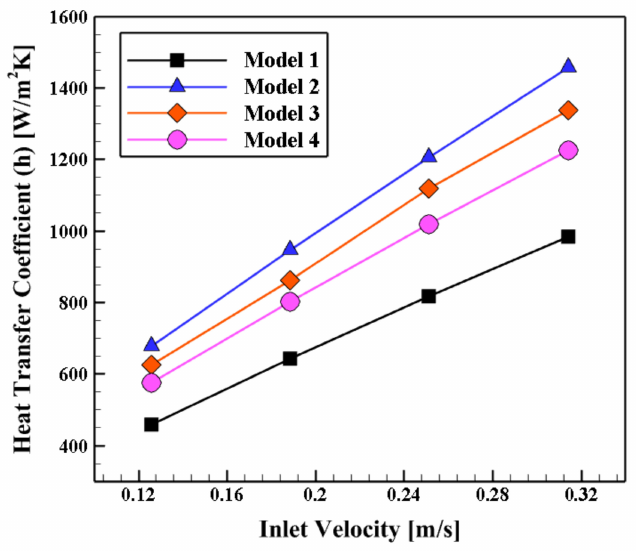
Figure 7. Heat transfer coefficient variation with the inlet velocity for various models at P = 500 mm.